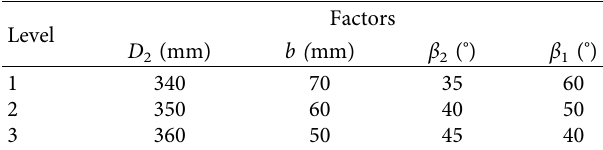
Table 5: Orthogonal experimental factors.